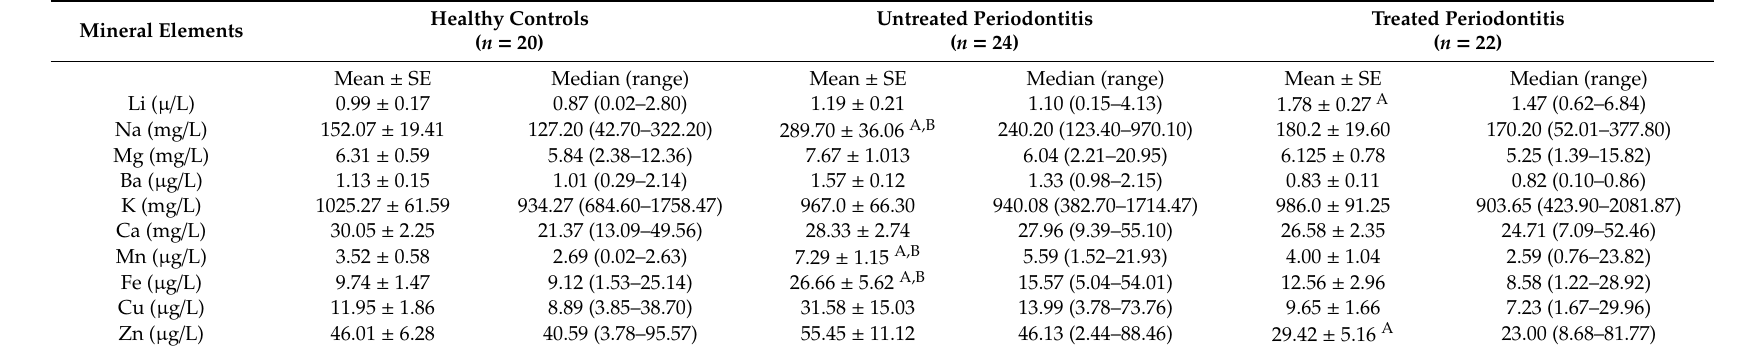
Table 2. Concentration of mineral elements in saliva of periodontitis patients and healthy